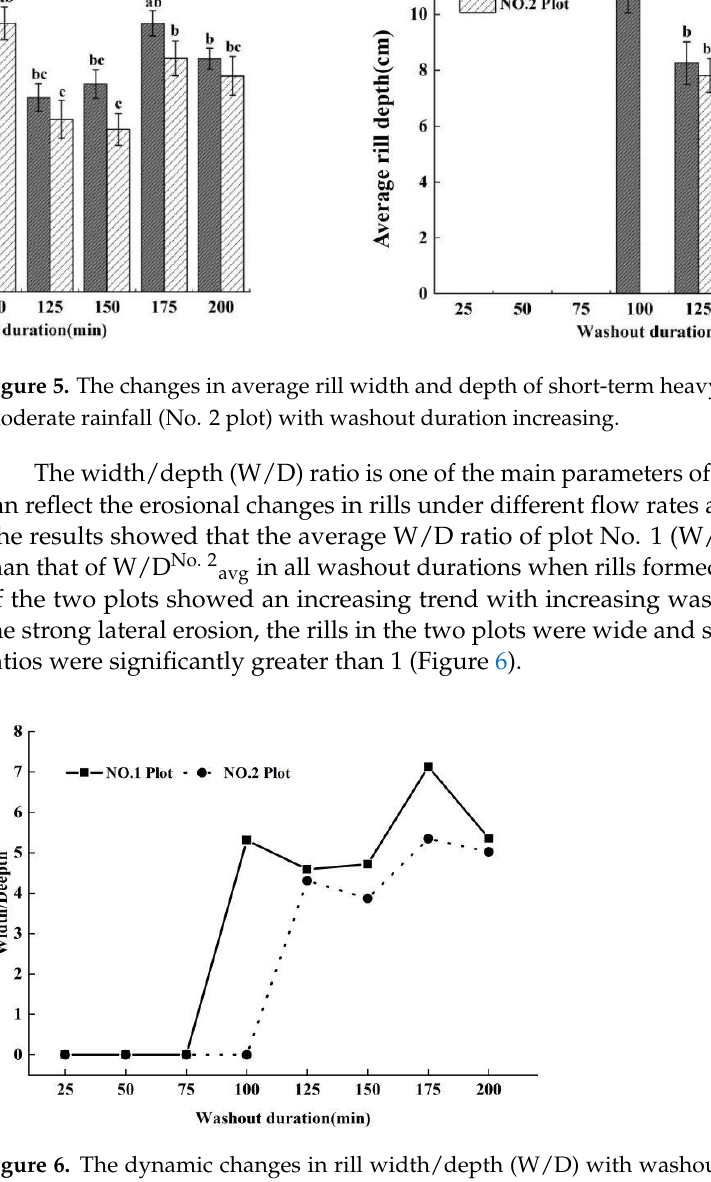
Figure 5. The changes in average rill width and depth of short-term heavy rainfall (No. 1 plot) and moderate rainfall (No. 2 plot) with washout duration increasing.